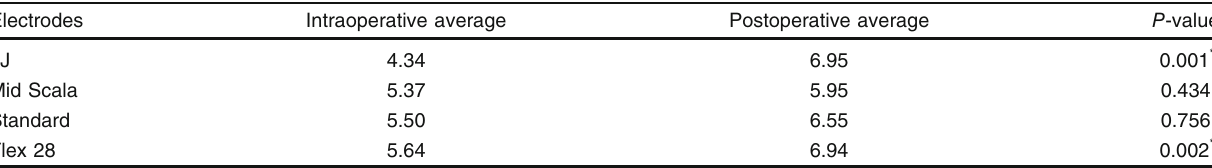
Table 1 Comparison between intraoperative and postoperative mean average of telemetry measure for all electrodes Electrodes